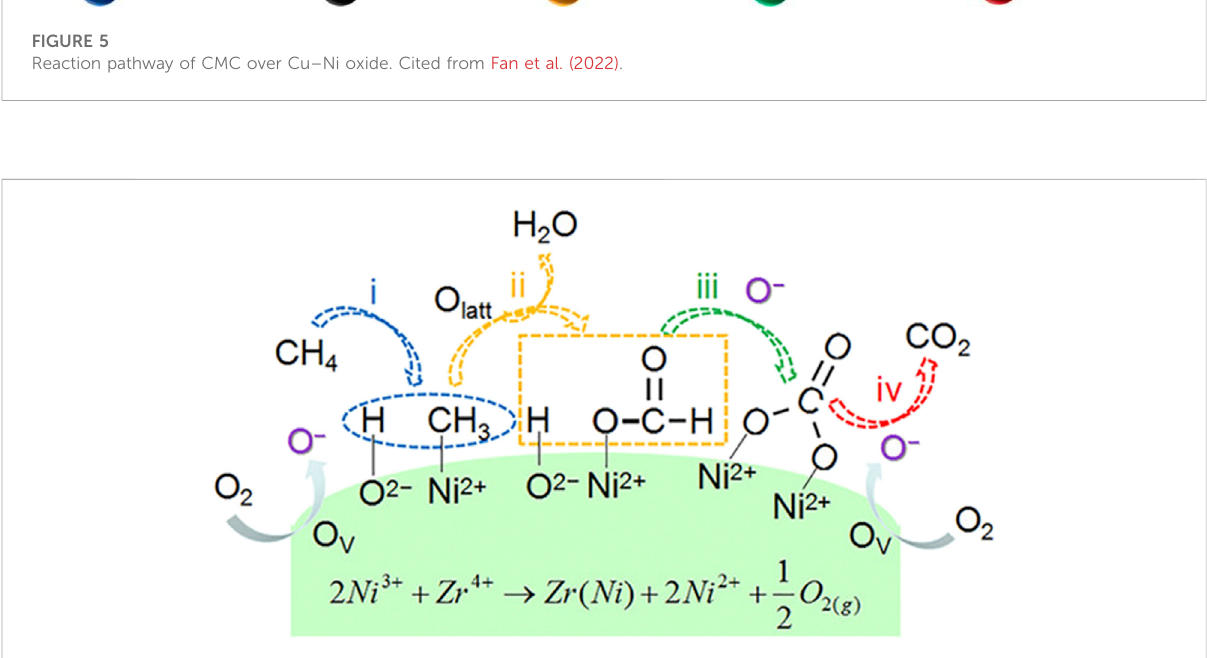
FIGURE 6 Reaction pathway for methane combustion over Ni 1 − x Zr x O 2 − δ catalysts. Reprinted with permission from Wang et al. (2021). Copyright (2021) American Chemical